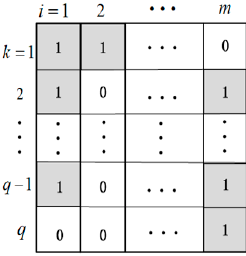
Figure 7. 2D binary coding satisfying the constraint condition.